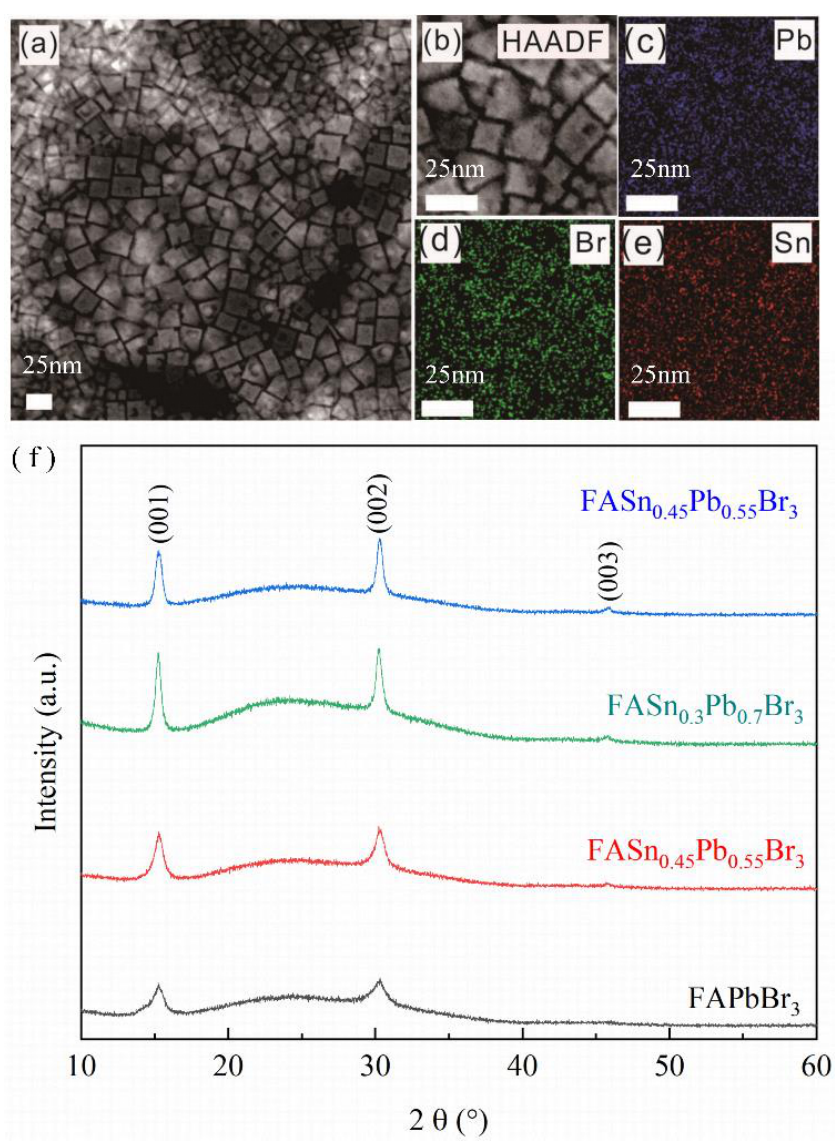
Figure 1. ( a ) TEM image of the FAPb 0.7 Sn 0.3 Br 3 nanocrystal ( b ) High − angle dark field image of the FAPb 0.7 Sn 0.3 Br 3 nanocrystal ( c ) Pb ( d ) Br, and ( e ) Sn element mapping results ( f ) XRD patterns of FAPb 1-x Sn x Br 3 nanocrystalline films with different Pb/Sn ratios.